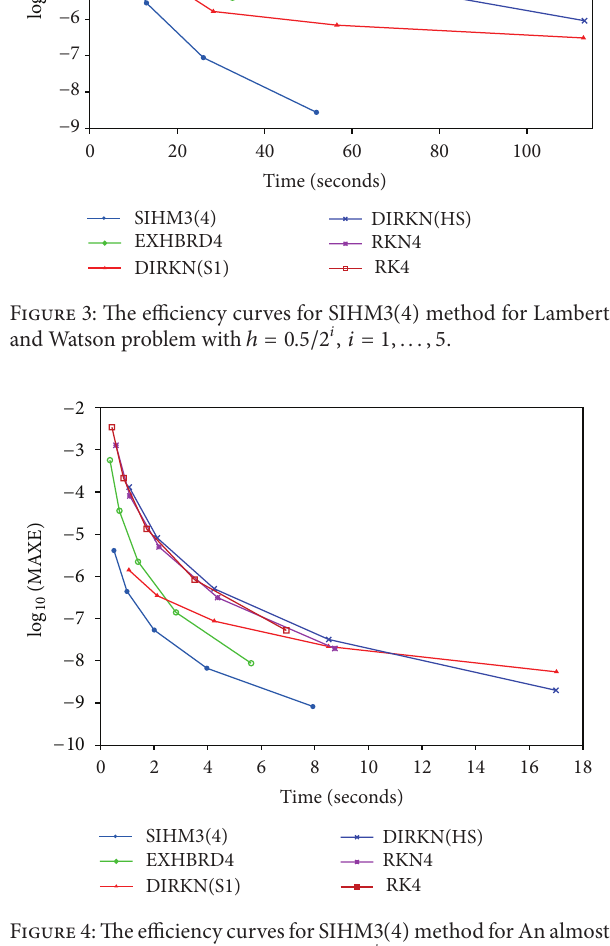
Figure 4: The efficiency curves for SIHM3 (4) method for An almost Periodic Orbit problem with ℎ = 0.125/2 𝑖 , 𝑖 = 1,...,5